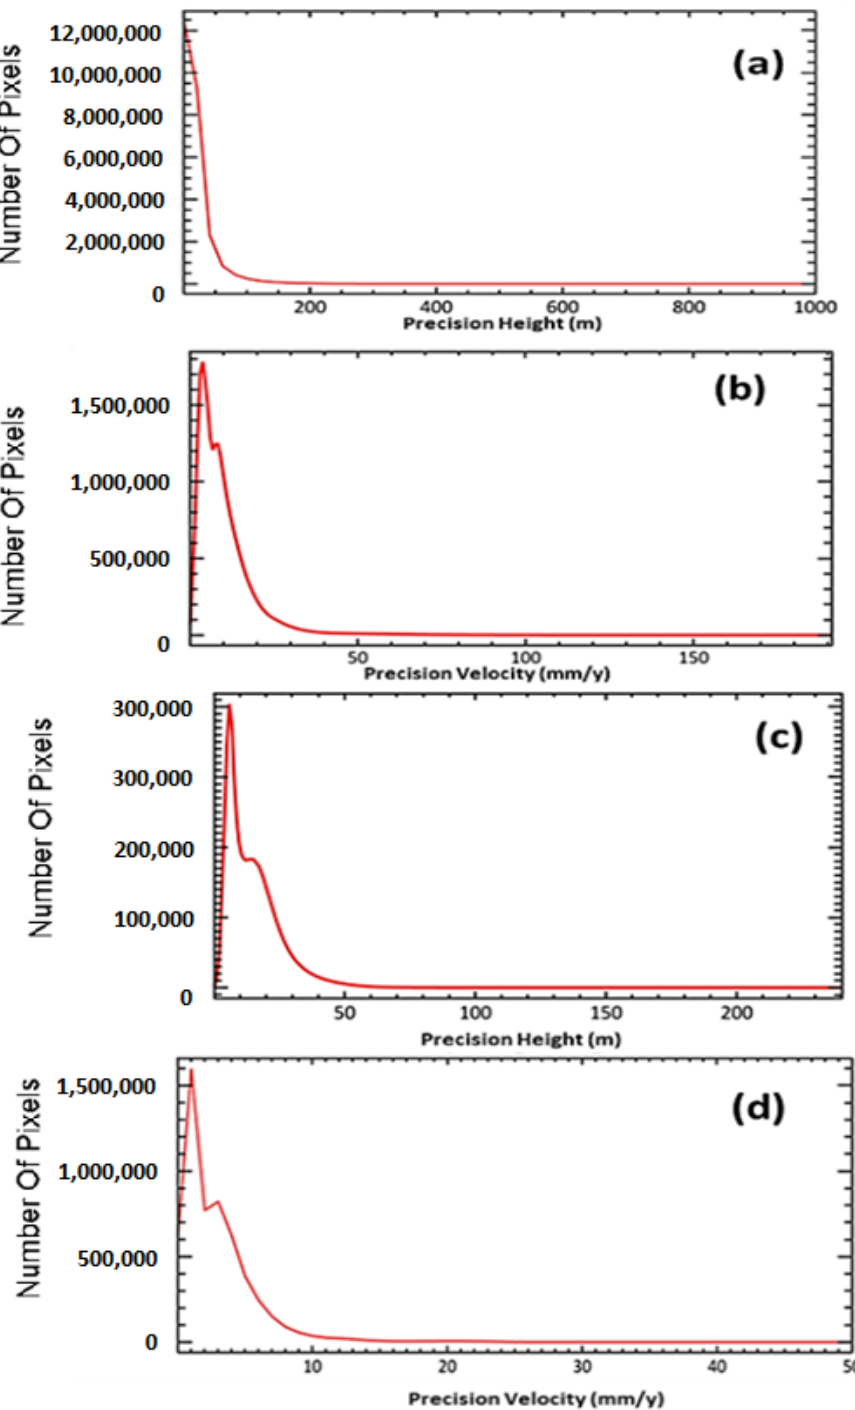
Figure 9. ( a ) Statistics histograms of precision height and ( b ) the corresponding height precision for ALOS/PALSAR-2 data. ( c ) Representative histograms of Sentinel-1 data precision height and ( d ) the corresponding precision velocity.